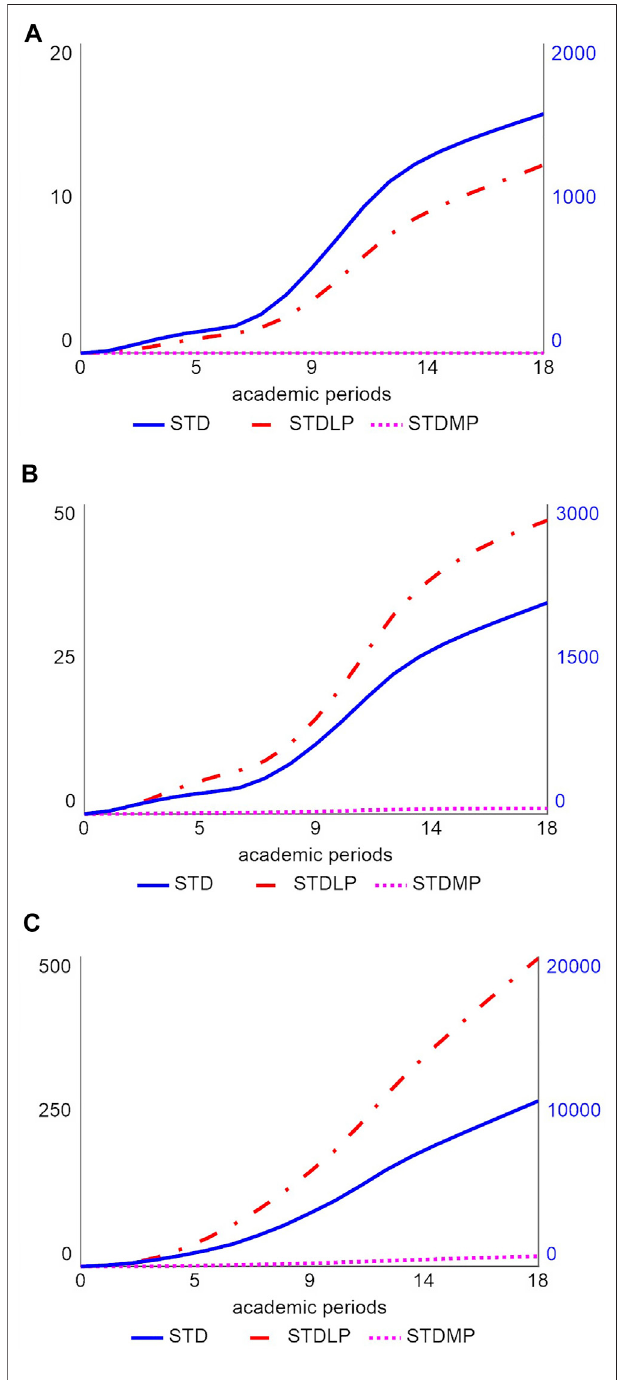
FIGURE4| Drop-outbehaviour by typeofacademic credit for SIM-1. Note: (A) presents technical training programmes, (B) technological training and (C) professional training. STD: Total number of dropouts per t . STDLP: Total number of dropouts with long-term credits per t . STDMP: Total number of dropouts with medium-term credits per t